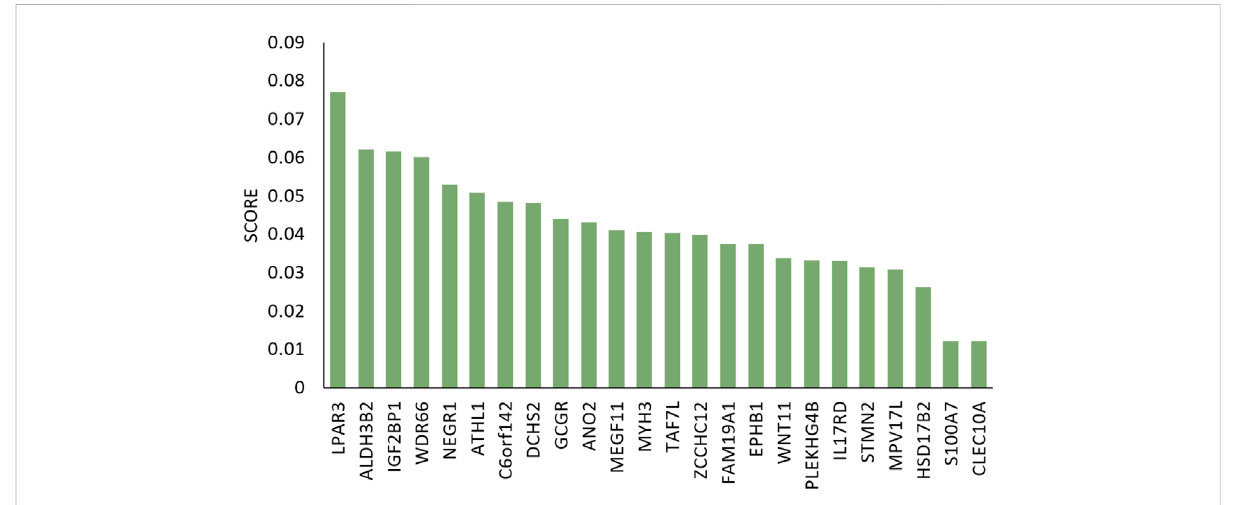
FIGURE 7 Gini importance scores of differential genes in C1 and C5 clusters.